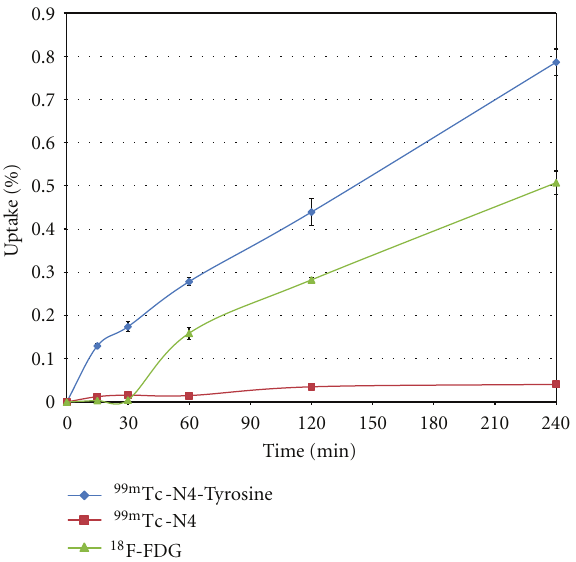
Figure 3: In vitro cellular uptake of 99m Tc-N4-Tyrosine, 99m Tc-N4, and 18 F-FDG in cells from rat breast tumor cell line 13762. Data are expressed as mean percent of cellular uptake ± standard deviation (%Uptake ± SD) measured at 15, 30, 60, 120, and 240 minutes after coincubation with 99m Tc-N4-Tyrosine.